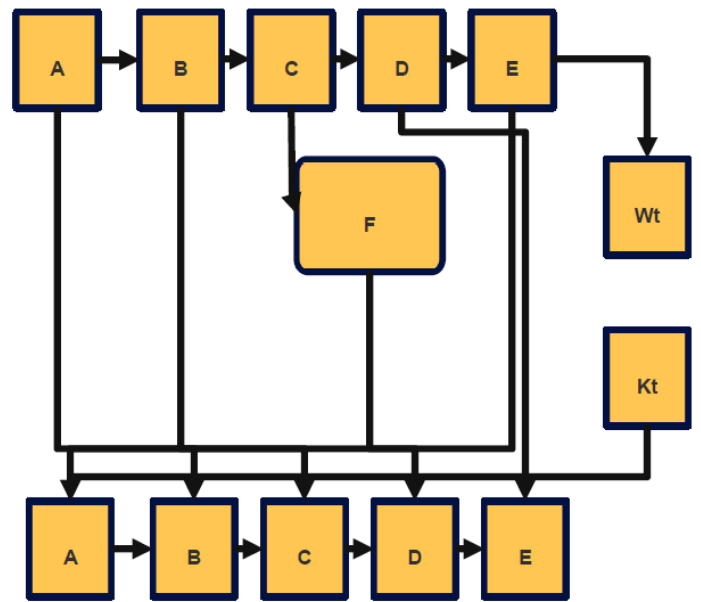
Figure 6. Iteration of SHA function.